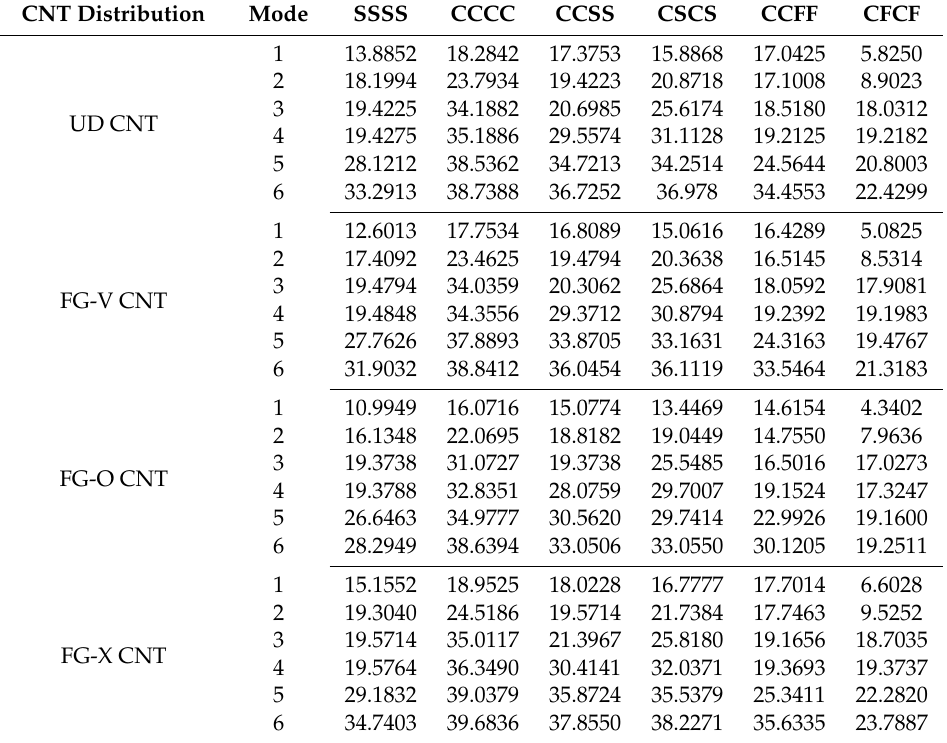
Table 7. Dimensionless first six natural frequencies ω for FG-CNT-reinforced plate with several types (cid:0) = 0.11, a / h = 10 (cid:1) . V ∗ of boundary conditions CNT